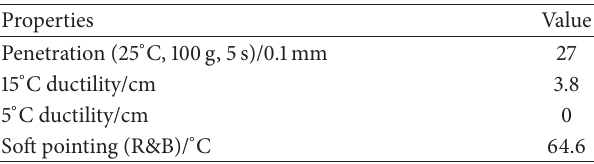
Table 1: Test results of extracted asphalt binder.